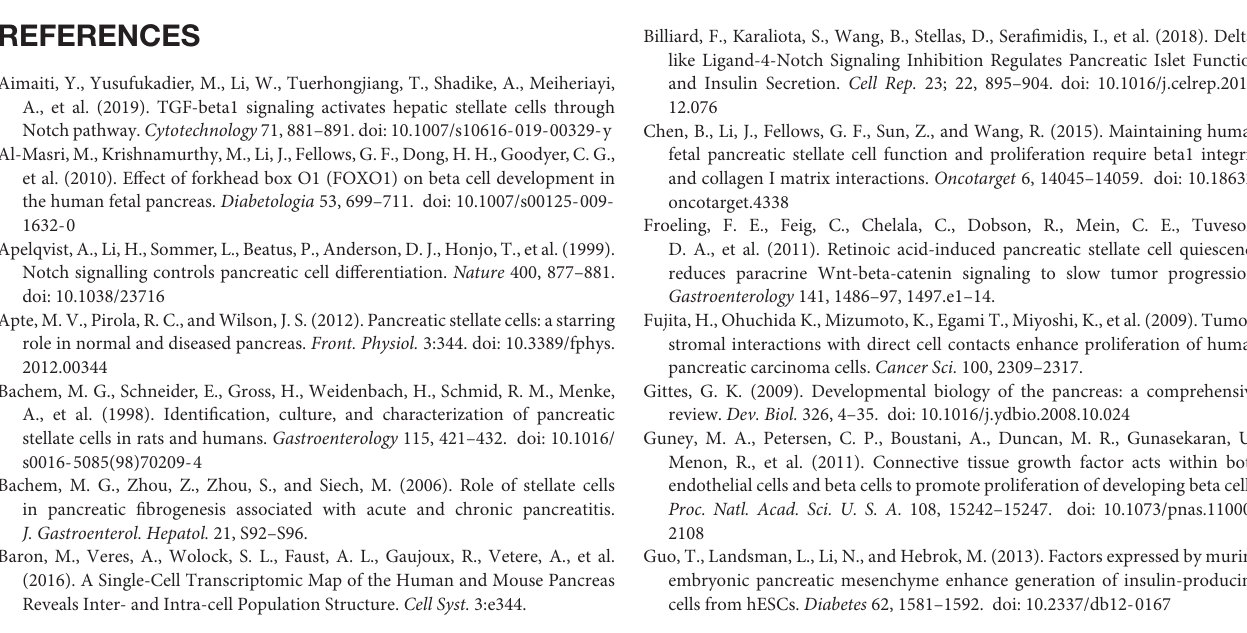
Supplementary Figure 1 | Co-culture models. Direct co-cultures (A) and Indirect co-cultures (B) models. Sub-confluent (80–90%) pancreatic stellate cells (PaSCs) in a 12-well plate were pretreated with or without 100 nM ATRA, then freshly isolated human fetal islet-epithelial cell clusters (hIECCs) were plated on top or in Millicell R (cid:13) Inserts and co-cultured in CMRL1066 media containing 5% FBS for 48 h. (C) 20% Conditioned PaSCs media culture. (D) Indirect co-cultures with Notch inhibition. Supplementary Figure 2 | (A) Phase-contrast images of PaSCs isolated from human fetal pancreas in our lab and purchased HPaSteC (catalog #3830) from ScienCell Research Labs, United States. (B) Western blot gels present PaSC markers and growth factors of desmin, α SMA, vimentin, GFAP, TGF β 1 and CTGF from both cultured PaSCs and HPaSteC cells. Supplementary Figure 3 | (A) Freshly isolated human (18 weeks of fetal age) fetal islet-epithelial cell cluster (hIECC) containing a few PaSCs stained with desmin or α SMA (green, arrows); nuclei labeled by DAPI (blue). Scale bar: 25 µ m. (B) The percentage of desmin + and α SMA + cells present in the hIECC was quantified, data are expressed as mean ± SEM ( n = 5 experiments/treatment group). Supplementary Figure 4 | Representative immunofluorescence staining images for NKX6-1, insulin (red) or amylase (green) in hIECCs during a direct co-culture with PaSCs for 48 h, and the nuclear stain DAPI (blue). Scale bar: 25 µ m. Magnified images are shown in insets. Supplementary Figure 5 | (A) PaSC viability by MTT showed a significant increase with 1–10 ng/ml TGF β 1 treatment. ∗ p < 0.05, ∗∗ p < 0.01 vs. 0 ng/ml. (B) The percentage of insulin + cells in hIECCs cultured with 20% PaSC conditioned medium (closed squares) or 10 ng/ml TGF β 1 (open triangles) compared to controls (closed circles). Data are expressed as mean ± SEM ( n = 3–5 experiments/treatment group). Supplementary Table 1 | Antibodies for immunohistochemistry, immunofluorescence and western blot analyses. Supplementary Table 2 | Sequences of primers used in Real-time RT-PCR assays. Supplementary Table 3 | List of genes for pancreatic stellate cell markers and associated notch signaling expressed during human fetal pancreatic